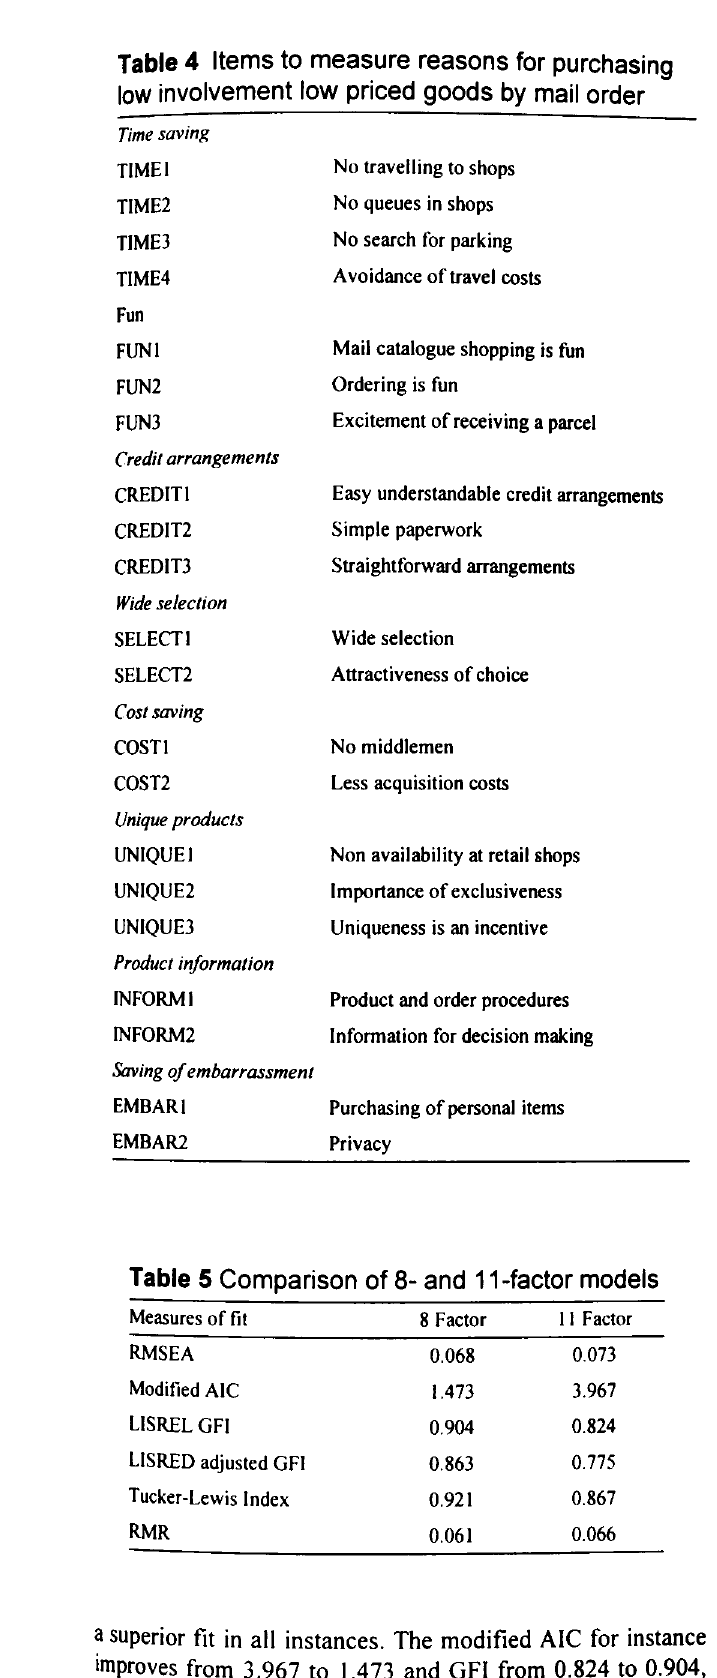
Table 4 Items to measure reasons for purchasing low involvement low priced goods by mail order